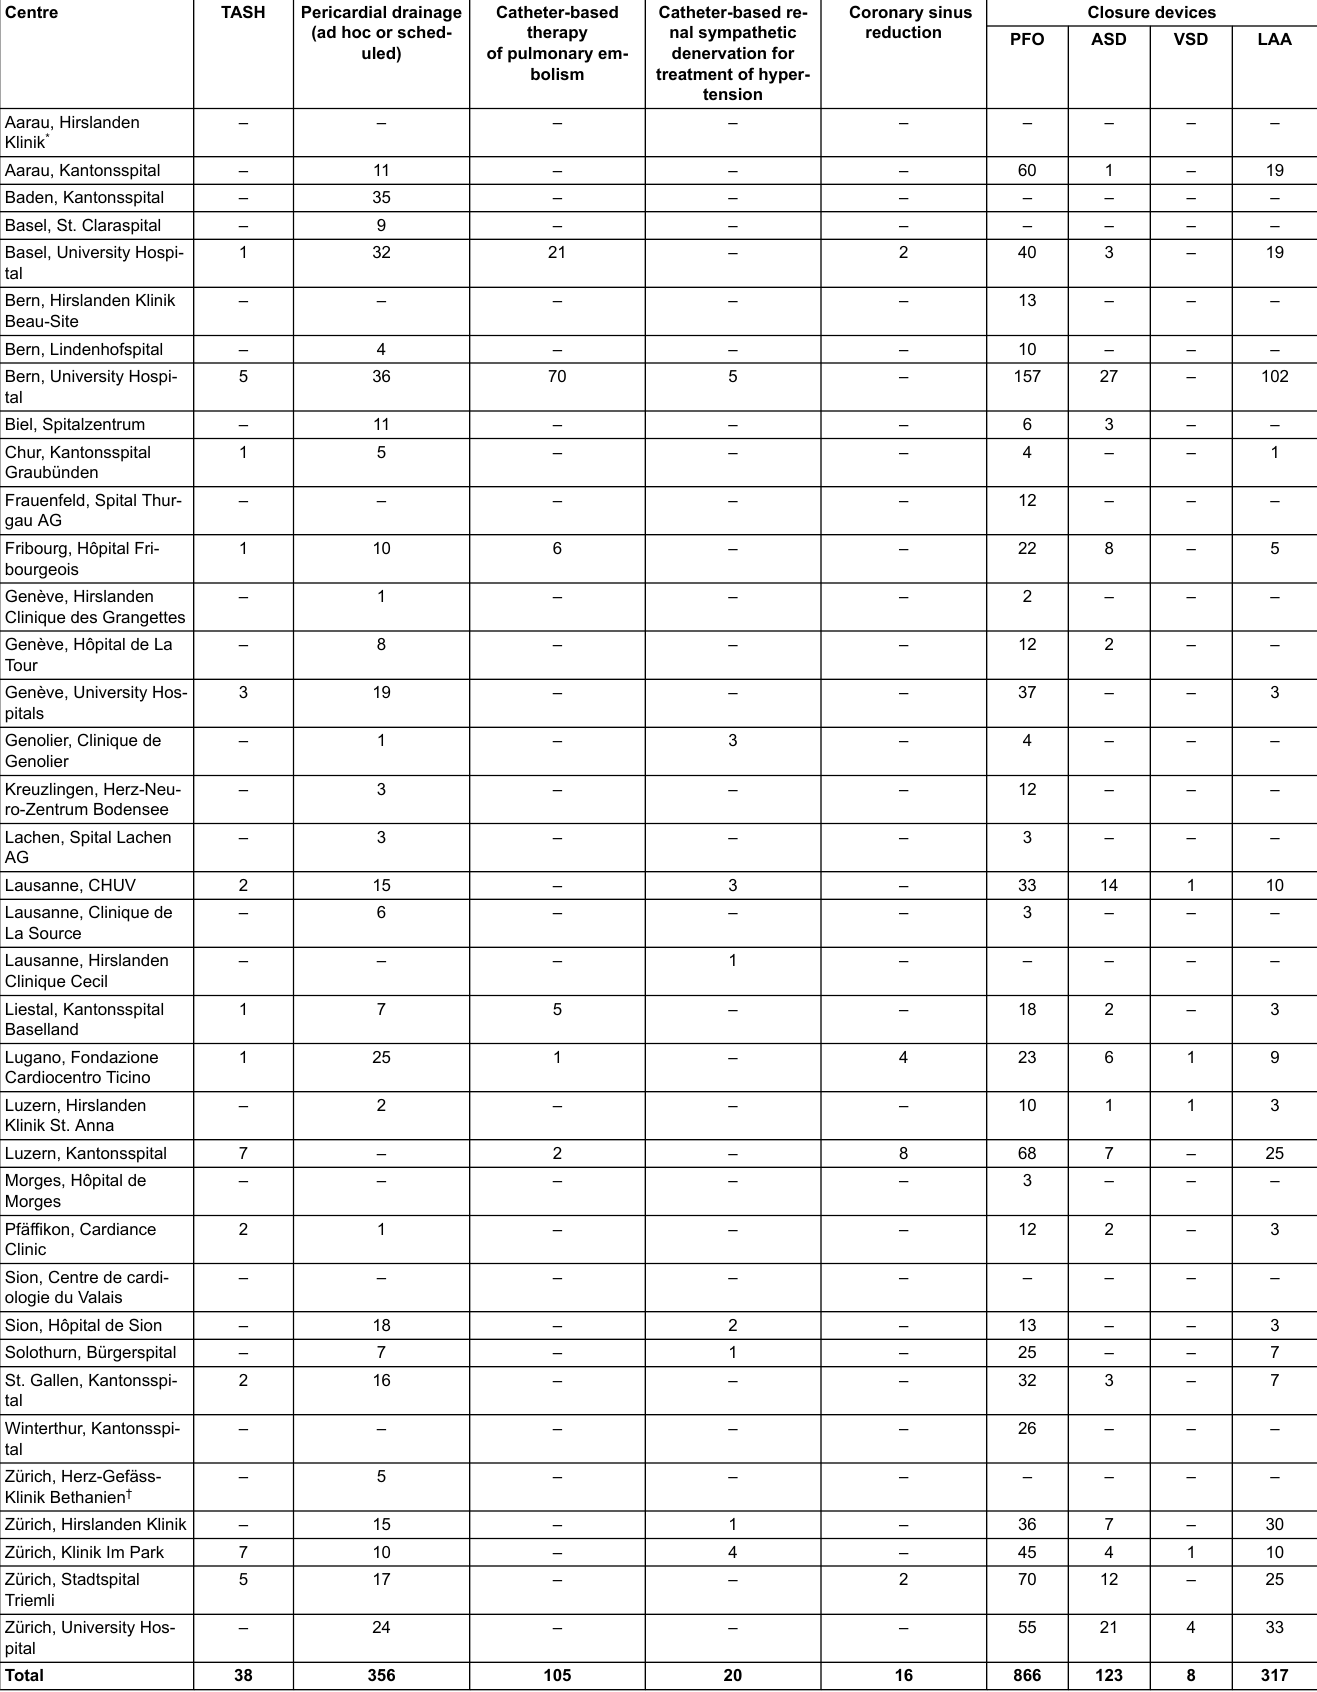
Table 8: Non-valvular structural heart and catheter-based pulmonary/renal interventions in Switzerland 2019. Centre TASH Pericardial drainage (ad hoc or sched- uled)